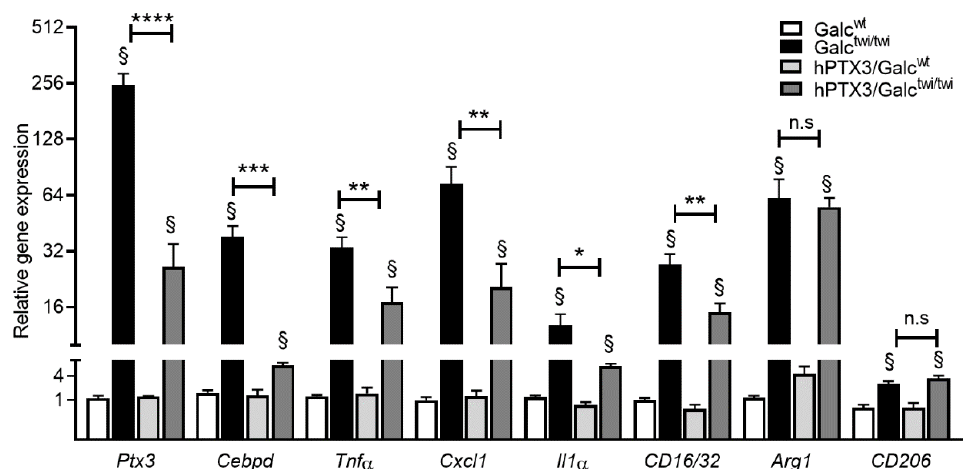
Figure 7. qPCR analysis of the spinal cord of hPTX3/Galc wt and hPTX3/Galc twi/twi mice. Steady state mRNA levels of the indicated genes were evaluated by qPCR in the spinal cord of hPTX3/Galc wt and hPTX3/Galc twi/twi mice and compared to those measured in the corresponding control Galc wt and Galc twi/twi mice harvested at P35. Data were normalized to Gapdh expression and are the mean ± SEM of 7 – 10 animals per group. n.s., not significant; * p < 0.1; ** p < 0.05; *** p < 0.01, **** p < 0.001 for Galc twi/twi versus hPTX3/Galc twi/twi mice; §, p < 0.001 for Galc wt versus Galc twi/twi mice or for hPTX3/ Galc wt versus hPTX3/Galc twi/twi animals. One-way ANOVA with post hoc comparisons with adjustment for multiple comparisons (Sidak).